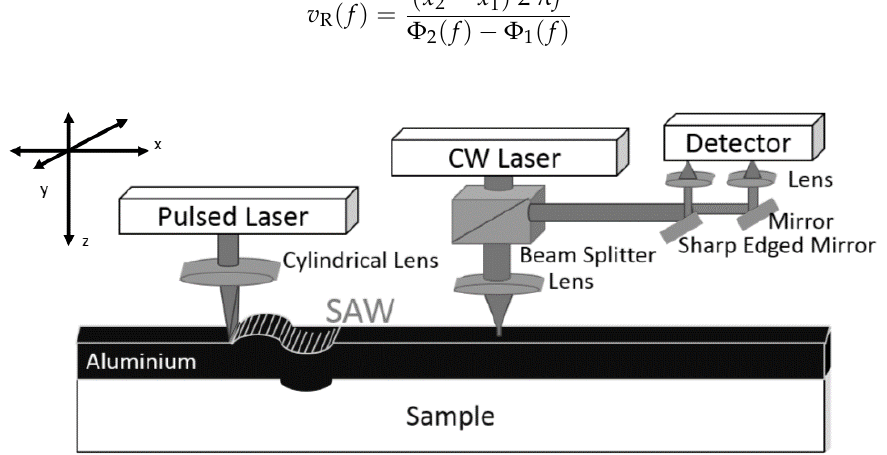
Figure 4. Schematic of laser-induced ultrasound (LUS) set-up; CW laser denotes a continuous wave laser, SAW denotes a surface acoustic wave.